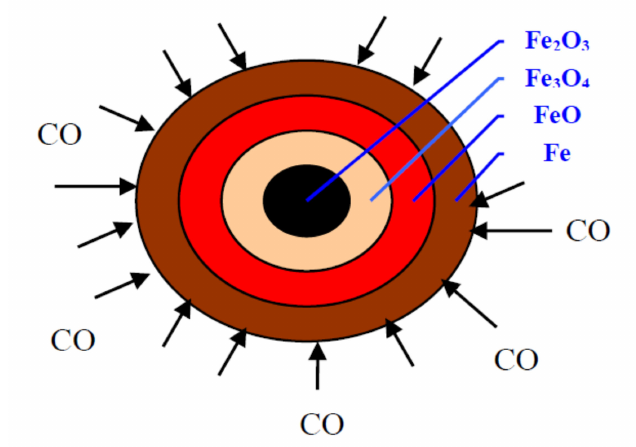
Figure 2. Spherical model of the reduction of iron ore pellet with